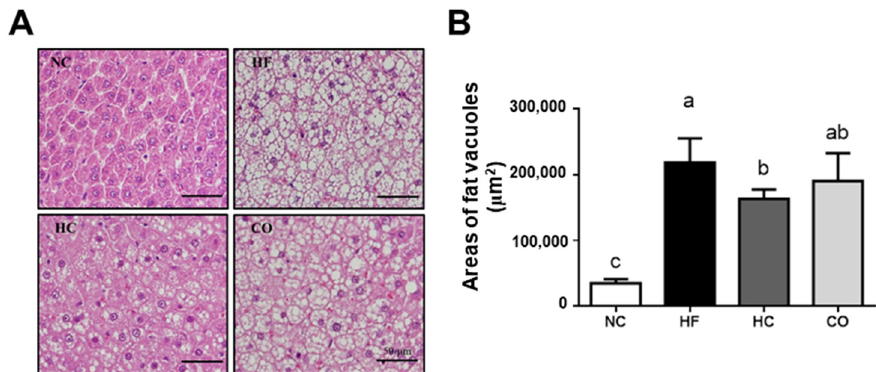
Figure 2. The changes in liver histological morphology in rats fed with different experimental diets for 12 weeks. ( A ) Liver tissue sections were stained with hematoxylin and eosin (H&E) staining. ( B ) Data are expressed as the mean ± S.D. for each group ( n = 8). Values with different superscript letters (a, b, c) are significantly different from each other ( p < 0.05). NC: Normal control diet (chow diet). HF: High-fat diet (chow diet + 10% lard). HC: HF diet + 5% high-molecular-weight chitosan. CO: HF diet + 5% chitosan oligosaccharides.